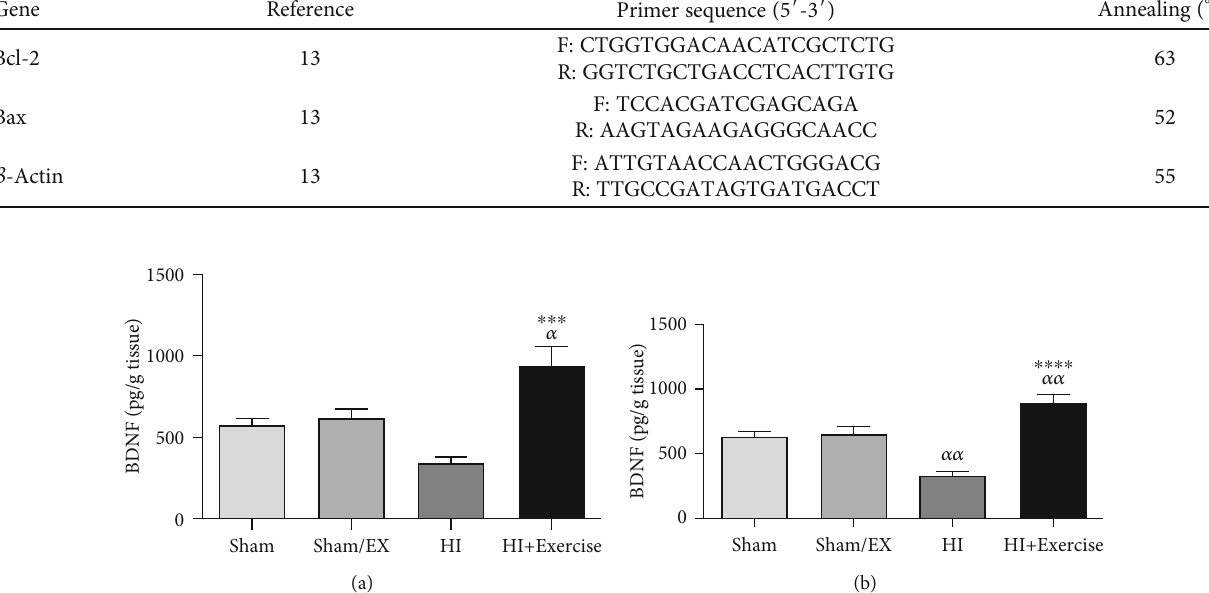
Figure 1: E ff ect of exercise during pregnancy on BDNF levels after HI in female (a) and male (b) pups brain. HI: hypoxia-ischemia. α P < 0 : 05 , αα P < 0 : 01 as compared with the sham and sham/EX. ∗∗∗ P < 0 : 001 , ∗∗∗∗ P < 0 : 0001 as compared with the HI. Data are expressed as the mean ± S : E : M : ( n = 10 ).